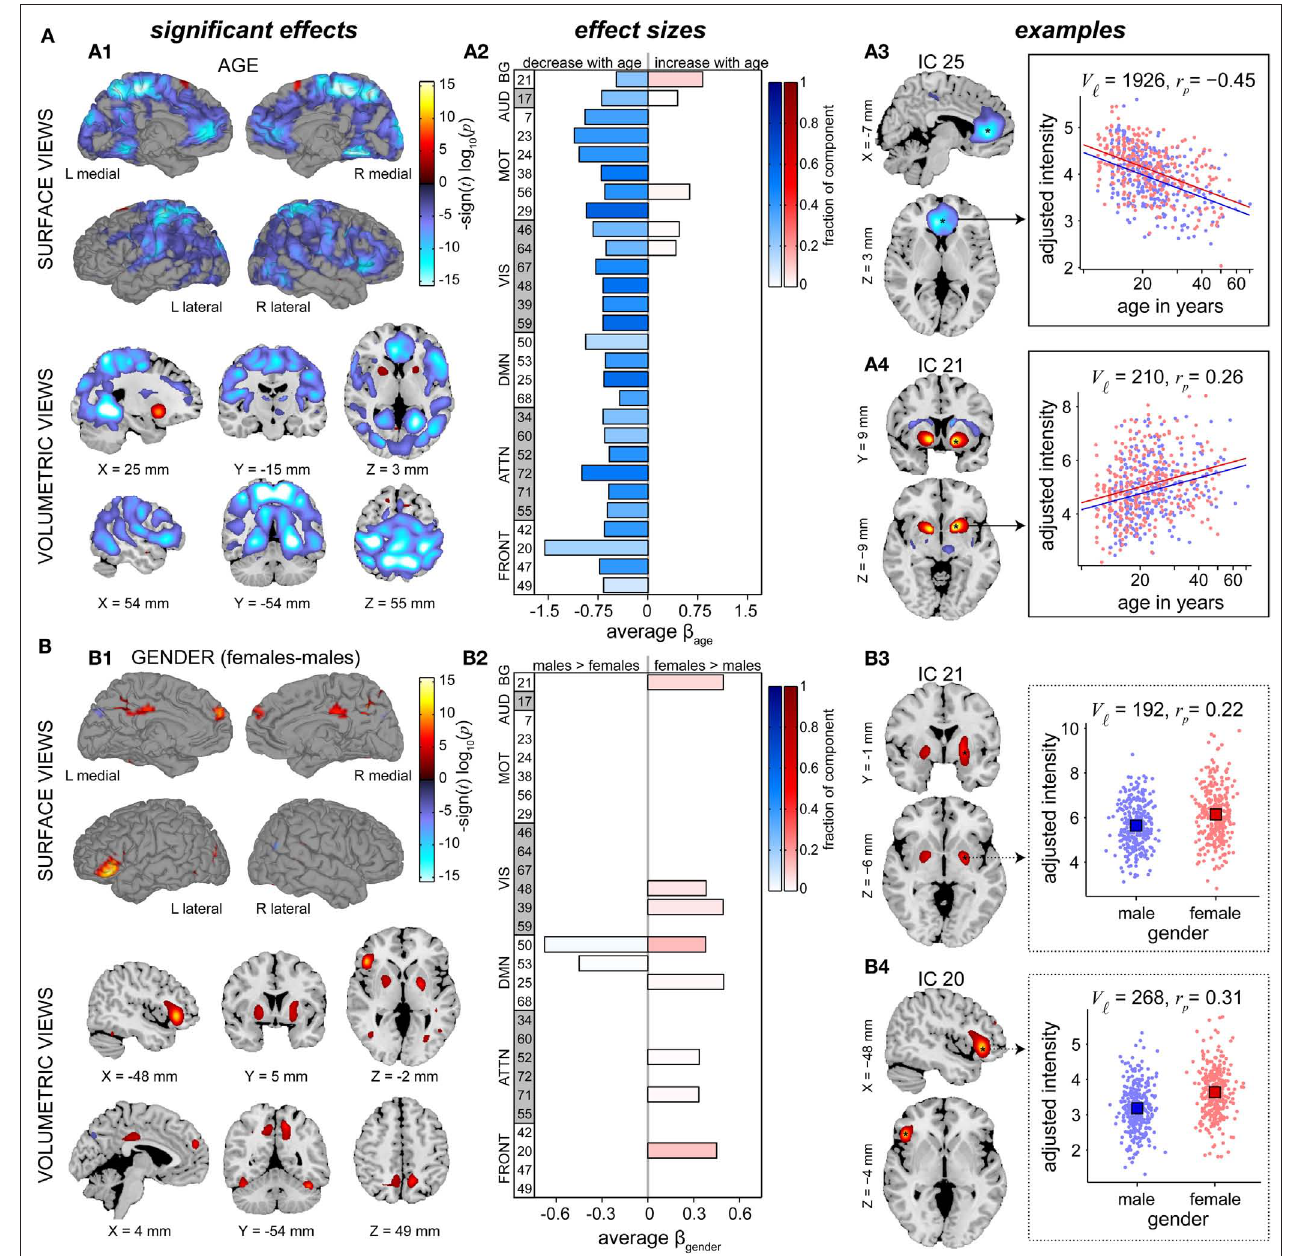
significant clusters with effects of the same directionality and the color of the FIGuRe 7 | univariate test results showing the effects age (A) and gender bar is proportional to the fraction of component voxels contributing to each (B) on SMs, in a similar format to Figure 6. Left panels (A1,B1) show surface effect. Right panels show examples of components with age effects ( A3 : IC 25, and volumetric maps depicting composite renderings of significant effects over anterior DMN, and A4 : IC 21, basal ganglia,) and gender effects ( B3 : IC 21, basal all RSNs, displayed as the − sign( t )log ( p ). Effects are considered significant if 10 ganglia, and B4: IC 20, left IFG). Scatter plots show the effects for a single test statistics exceeded the FDR threshold ( a = 0.01) with a cluster extent of at significant cluster (indicated by asterisks in the − sign( t ) log ( p ) maps), with the least 27 contiguous voxels. Middle panels (A2,B2) show bar plots of the average 10 b -values for the age (A2) and gender (B2) terms. b -Values were averaged over number of contributing voxels indicated on each plot ( V 